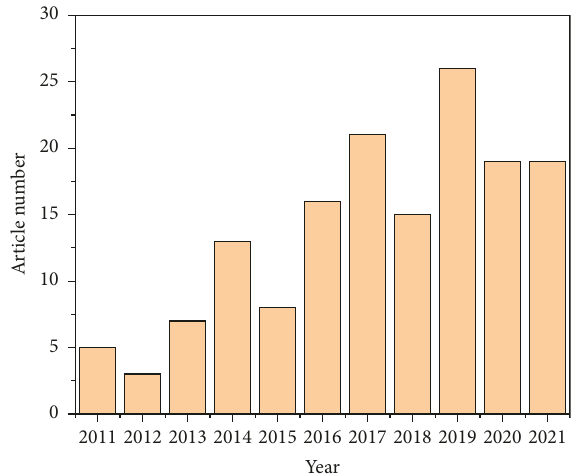
Figure 2: Annual publications from 2011 to 2021 searched in WOS and PubMed about the use of GeneXpert in tuberculosis.